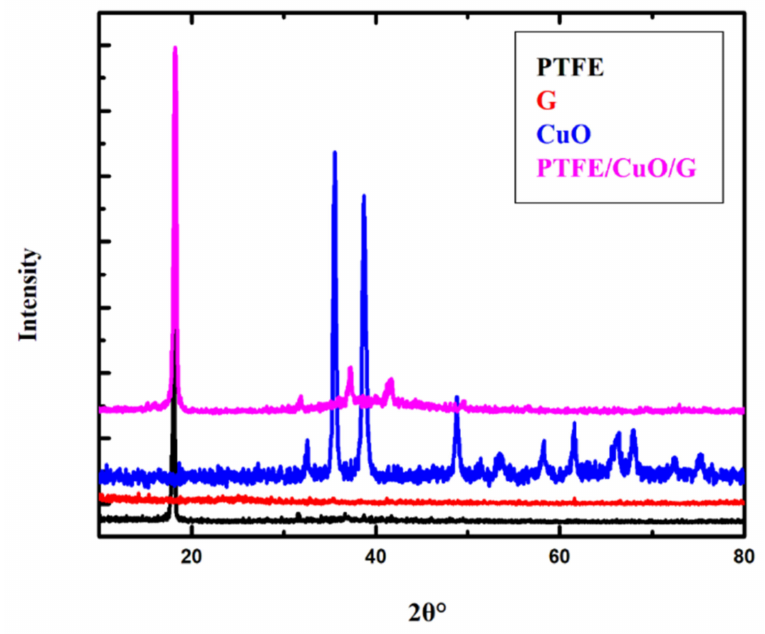
Figure 2. XRD diffraction pattern for PTFE, CuO, G, and PTFE/CuO/G